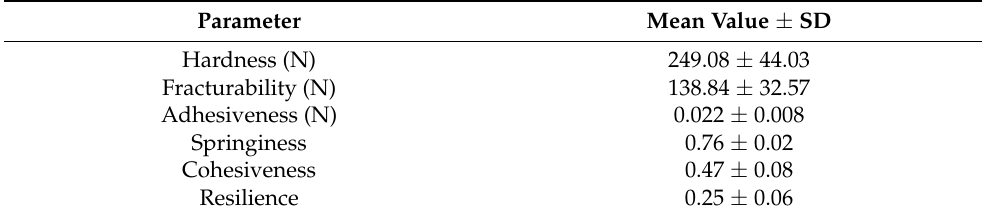
Table 2. Texture profile analysis of Ceiba aesculifolia subsp. parvifolia tuber pulp.